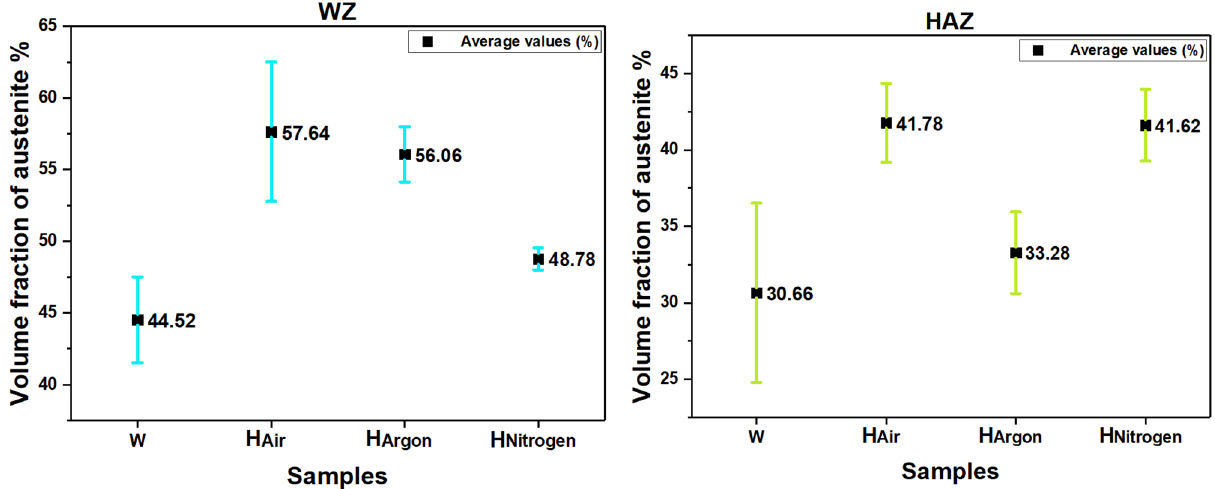
Figure 17. The volume fraction of austenite phase in heat affected zone and weld zone for the investigated